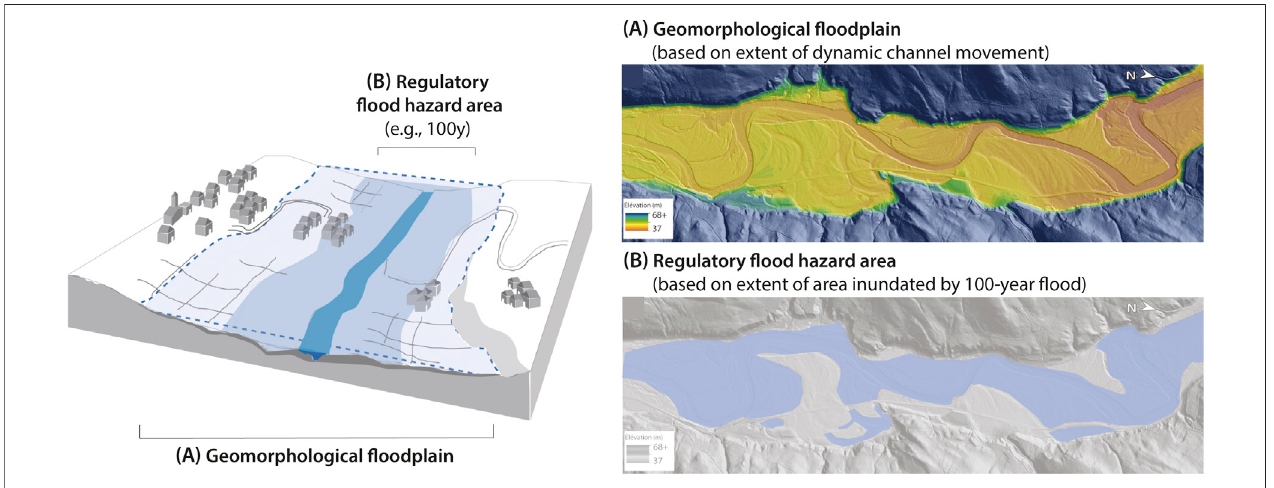
FIGURE 1 | Regulatory “ fl oodplain ” ( fl ood hazard area) as distinct from the geomorphological (natural) fl oodplain. (A) Extent of dynamic channel movement over time (geomorphological fl oodplain) vs. (B) extent of area inundated by the 100-year fl ood as de fi ned with hydrologic and hydraulic models (modi fi ed from Serra-Llobet et al.,